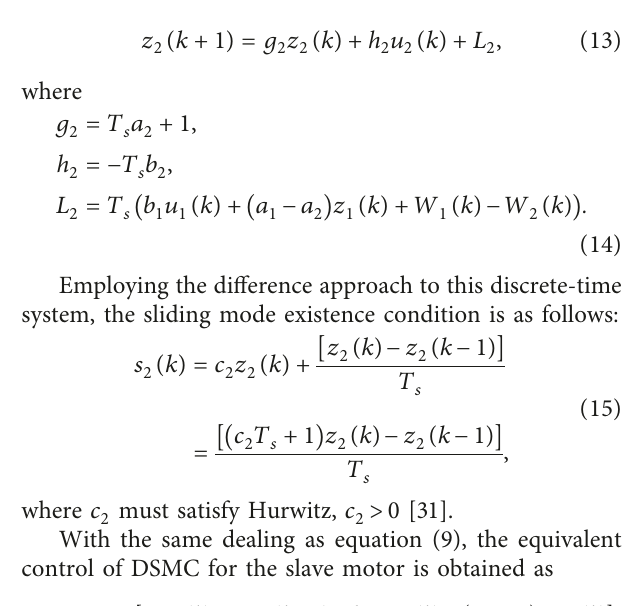
Figure 2: The control synchronization scheme of two